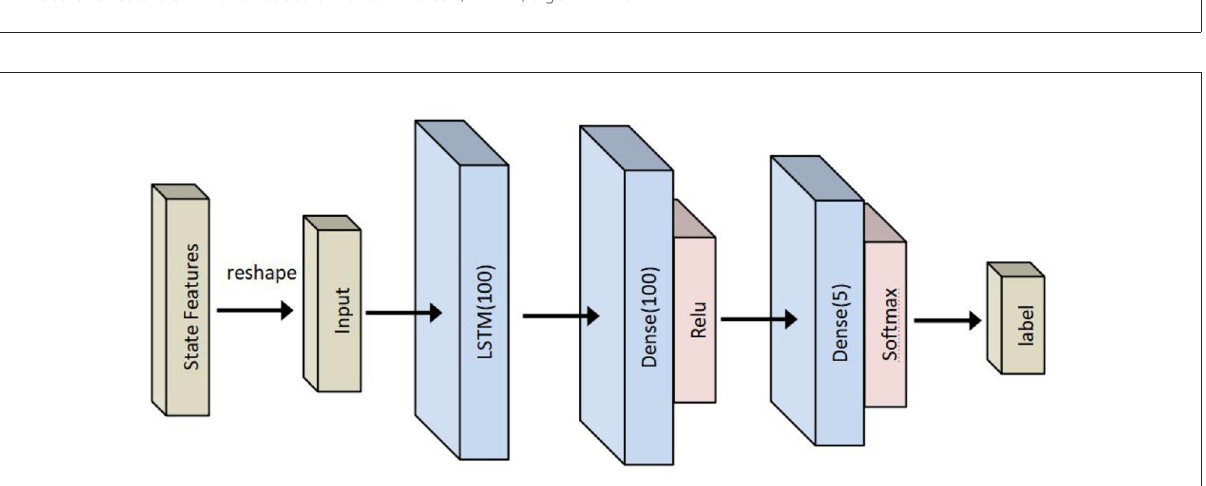
collected, labeled, and divided into segments. The force data segments are then used to extract the features of different collaborative states. Feature selections are conducted after feature extraction to reduce data redundancy and increase